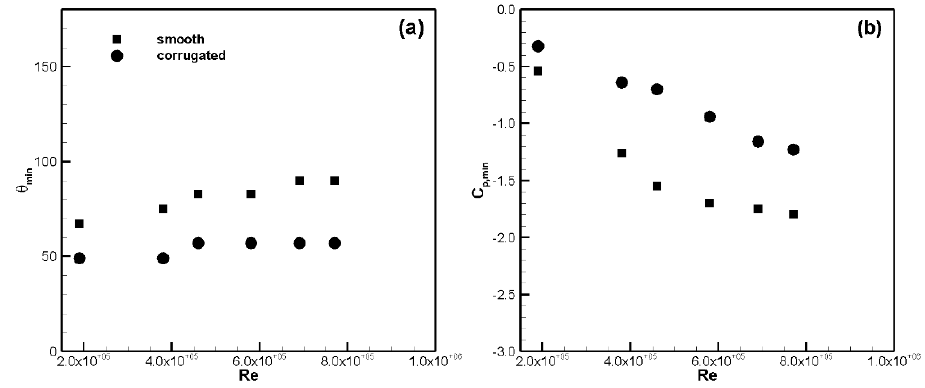
Figure 10. ( a ) θ min and ( b ) C p,min versus Reynolds number for the smooth and corrugated cylinders.